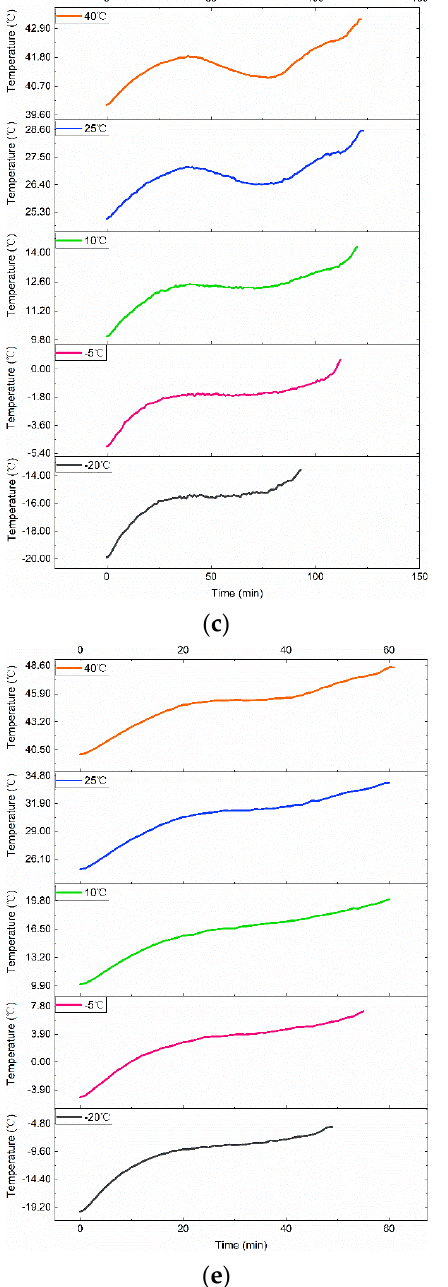
Figure 5. The temperature change curve of the battery surface during discharge: ( a ) 0.1C discharge rate; ( b ) 0.25C discharge rate; ( c ) 0.5C discharge rate; ( d ) 0.75C discharge rate; ( e ) 1C discharge rate.